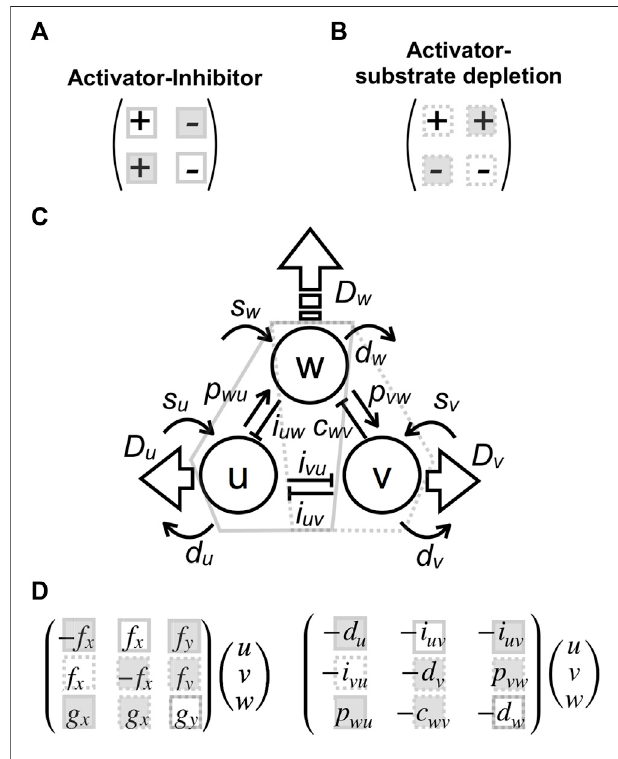
FIGURE 3 | Parameter correspondences to two-component systems and effects on pattern size. (A,B) Two conditions that generate a Turing pattern: activator – inhibitor type (A) or activator – substrate – depletion type (B) with different signs of reaction parameters. (C) Correspondence between parameters in the present tree-component model and the two- component systems. Interactions included in conditions (A) and (B) are enclosed by solid and dashed polygons, respectively. (D) Matrix forms of reaction terms corresponding to the two-component system: the fi lled squares indicate the parameter that increases pattern size when the absolute value is decreased, and the open squares denote the opposite; the solid squares correspond to condition (A) , and the dashed ones correspond to condition (B)